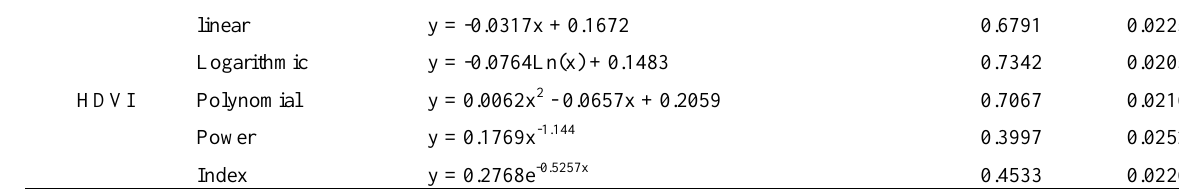
Table 4. The different modes between Indices and LAI using the data in situ measurement Using the data of in situ wheat measurements, the results of fitting different relationships between LAI and vegetation indices are shown in Table 4. It can be seen that the choice of the model has a significant influence on the estimation accuracy for LAI. For all of the NDVI, HDS 670 , and HDS 800 , the optimal approach is the polynomial. The best choice for the HDVI is logarithmic. The scatter diagrams between vegetation indices (HDS, NDVI, HDVI) and LAI with the optimal model are shown in Fig. 4, which illustrates that HDVI is a better proxy of LAI as a higher coefficient of determination